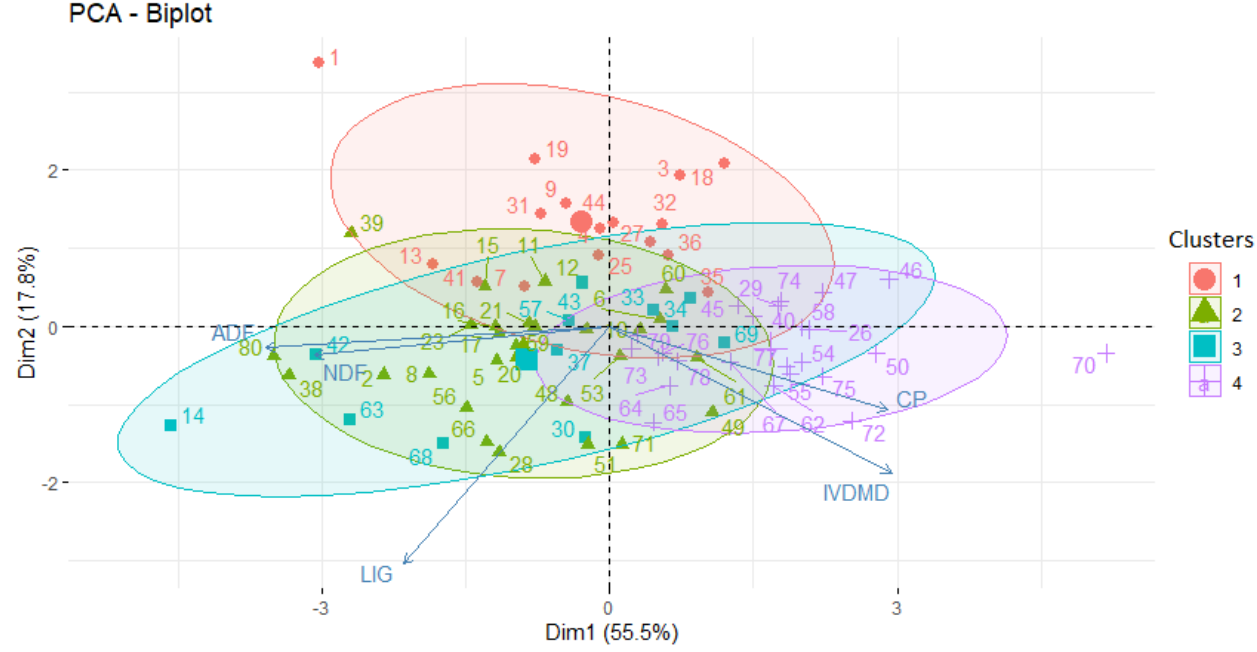
Figure 3. Dispersion of 80 Stylosanthes scabra Vogel accessions in relation to the first two components and four Mahalanobis similarity clusters. The accessions are numbered as in Table 1 and grouped in four clusters as in Table 6.